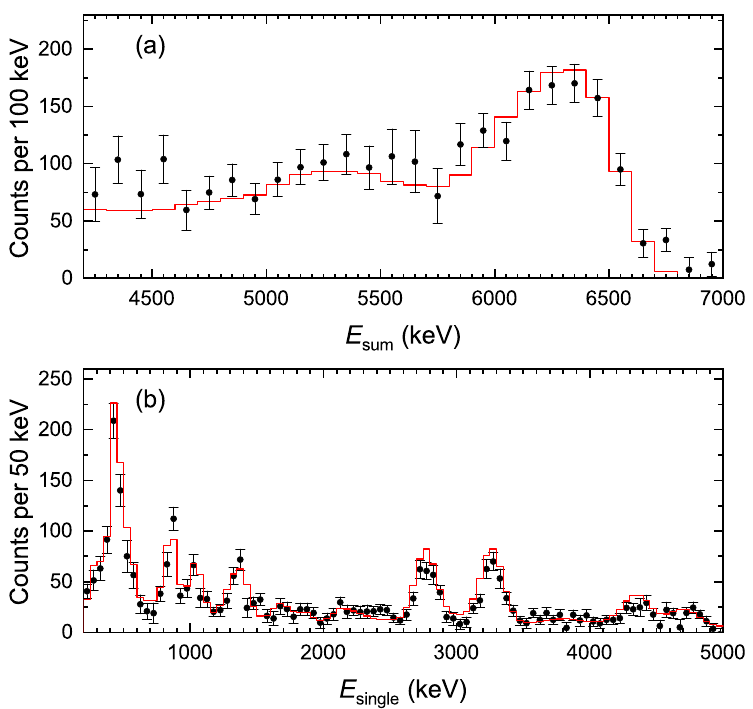
Figure 3: γ -ray spectra of the 92 keV 25 Mg(p , γ ) 26 Al resonance (black-filled circle). (a) Sum spectrum after background subtraction, the red line represents the GEANT4 simulation normalized to the experimental data.(b) Single spectrum, the red line represents the fitting